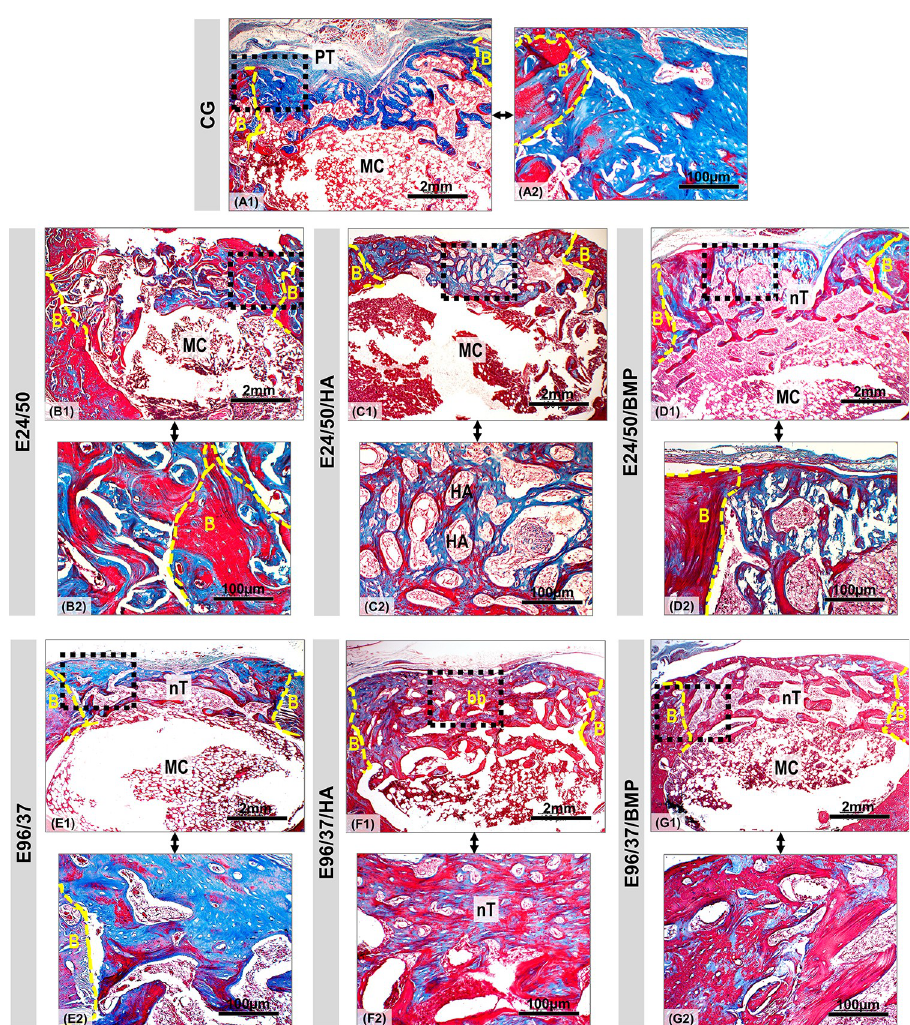
Fig 9. Panoramic view of bone defect created in distal femoral metaphysis in rats. Defect area in the CG, E24/50, E24/50/HA, E24/50/BMP, E96/37, E96/37/HA and E96/37/BMP (A1-G1) experimental groups at 42 days. All experimental groups presented trabecular bone formation from the remnant cortical border in transition from immature to mature bone, but without complete healing of the surgical wound. In the E96/37/HA treated defect, the bone trabeculae were more mature, thicker and more organized, forming a bone bridge connecting the defect edges. Masson’s trichrome staining: new bones with blue dye and mature bones with red dye. Periosteal tissue (PT); defect border (B); medullary canal (MC); neoformed bone trabeculae in the cortical region (nT); bone bridge (bb); Hydroxyapatite particle (HA). Masson’s trichrome staining of defect area. Original 4x magnification, Bar: 2mm. Inset 40x magnified images (A2-G2). Bar: 100 μ